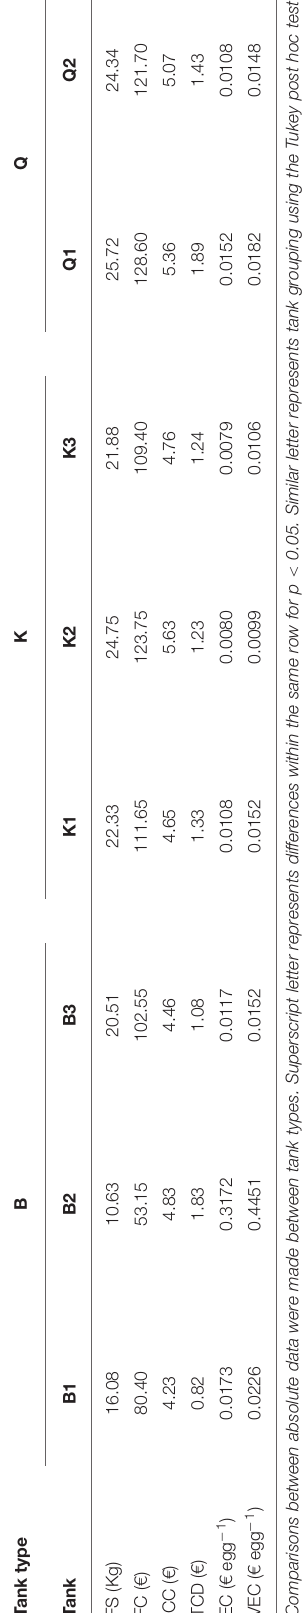
FIGURE 7 | Number of eggs obtained in each batch and in each tank during the reproduction stage of experiment.